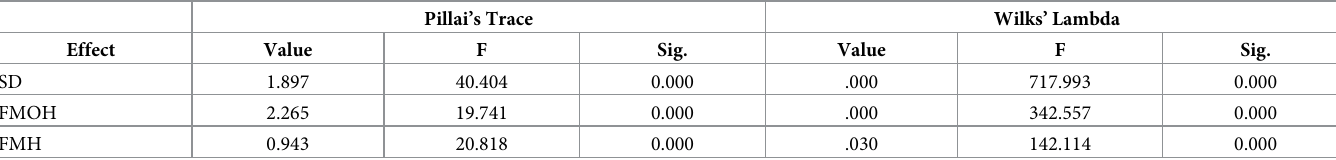
Table 3. Results of tests to evaluate the appropriateness of the multivariate test of